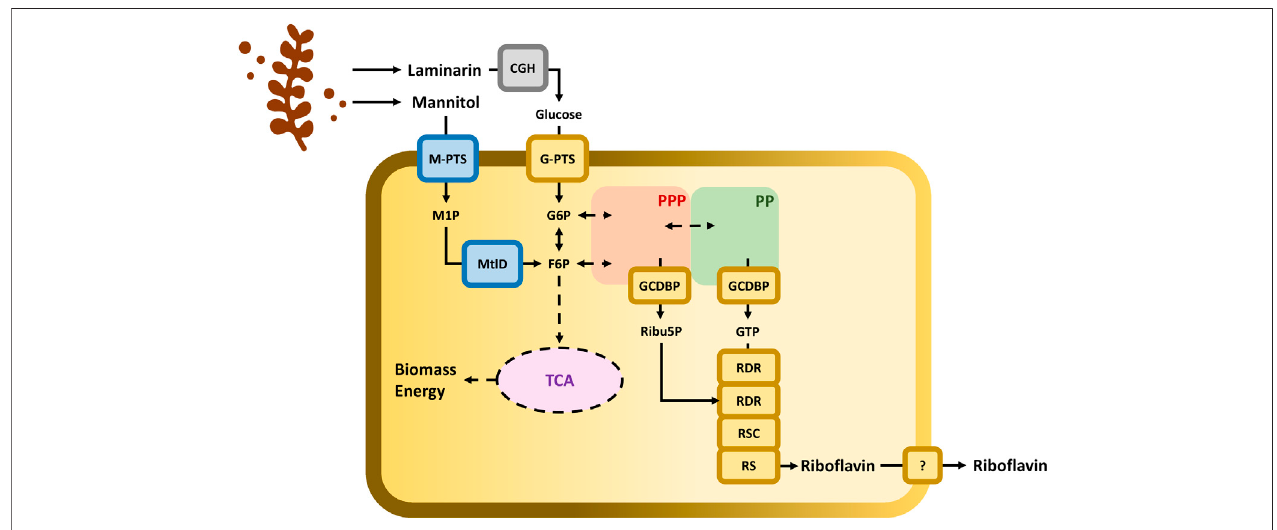
FIGURE 1 | Schematic representation of C. glutamicum cell factory with the metabolic connection between the utilization of brown seaweed-derived carbohydrates and the ribo fl avin biosynthetic pathway. Pathways: The pentose phosphate pathway (PPP) is depicted with a red-shadowed shape; the purine pathway (PP) is depicted with a green-shadowed shape; and tricarboxylic acid (TCA) cycle is depicted with a purple shadowed shape. Enzymes: Endogenous enzymatic steps are depicted in yellow boxes. G-PTS, glucose-speci fi c PTS coded by ptsG ; GCDBP, GTP cyclohydrolase II/3,4-dihydroxy-2-butanone-4-phosphatesynthase codedby ribA ;RDR,bifunctionalribo fl avin-speci fi cdeaminase/reductasecodedby ribG ;RSC,ribo fl avinsynthasebetachaincodedby ribH ;andRS,ribo fl avinsynthase by ribC. Enzymatic steps implemented in C. glutamicum are depicted in blue boxes. M-PTS, mannitol-speci fi c PTS coded by mtlA or mtlAF; MtlD, mannitol-1- phosphate-5-dehydrogenase coded by mtlD . Pretreatment of laminarin with commercial enzymes containing cellulases, ß-glucosidases, and hemicellulose (CGH) is depicted in grey box. Metabolites: M1P, mannitol 1-phosphate; G6P, glucose 6-phosphase; F6P, fructose 6-phosphate; Ribu5P, ribulose 5-phosphate; and GTP, Guanosine